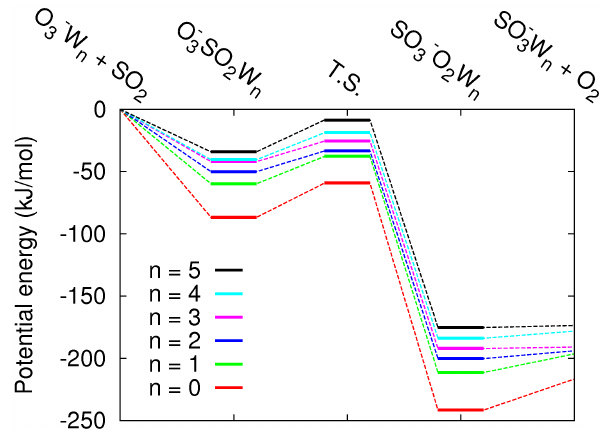
Fig. 3. Relative potential energy of the most important structures involved in the oxidation of SO 2 to SO 3 by an anionic O − cluster, n = 0–5. “W” is shorthand for water. The values are tabu- lated in the